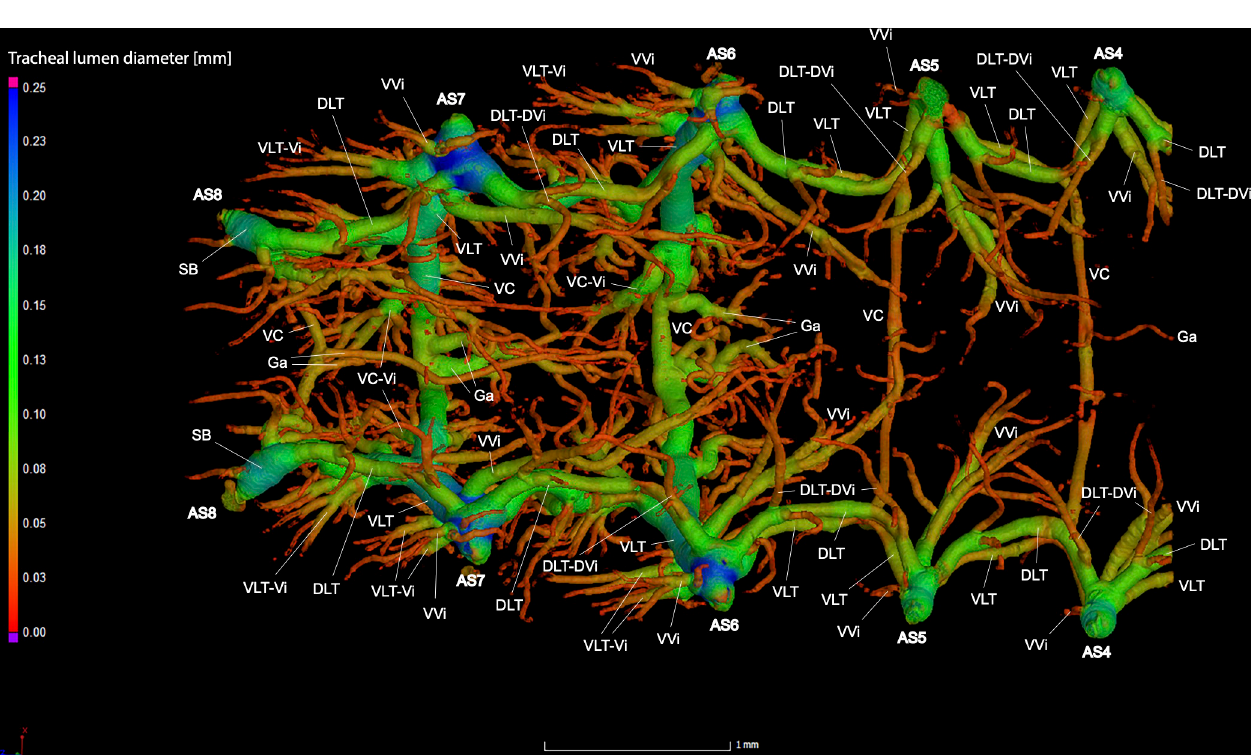
Fig 12. Dorsal view of the abdominal tracheal system in adult male Photinus pyralis with smaller tracheae digitally removed. https://doi.org/10.1371/journal.pone.0268112.g012 PLOS ONE | https://doi.org/10.1371/journal.pone.0268112 June 1,